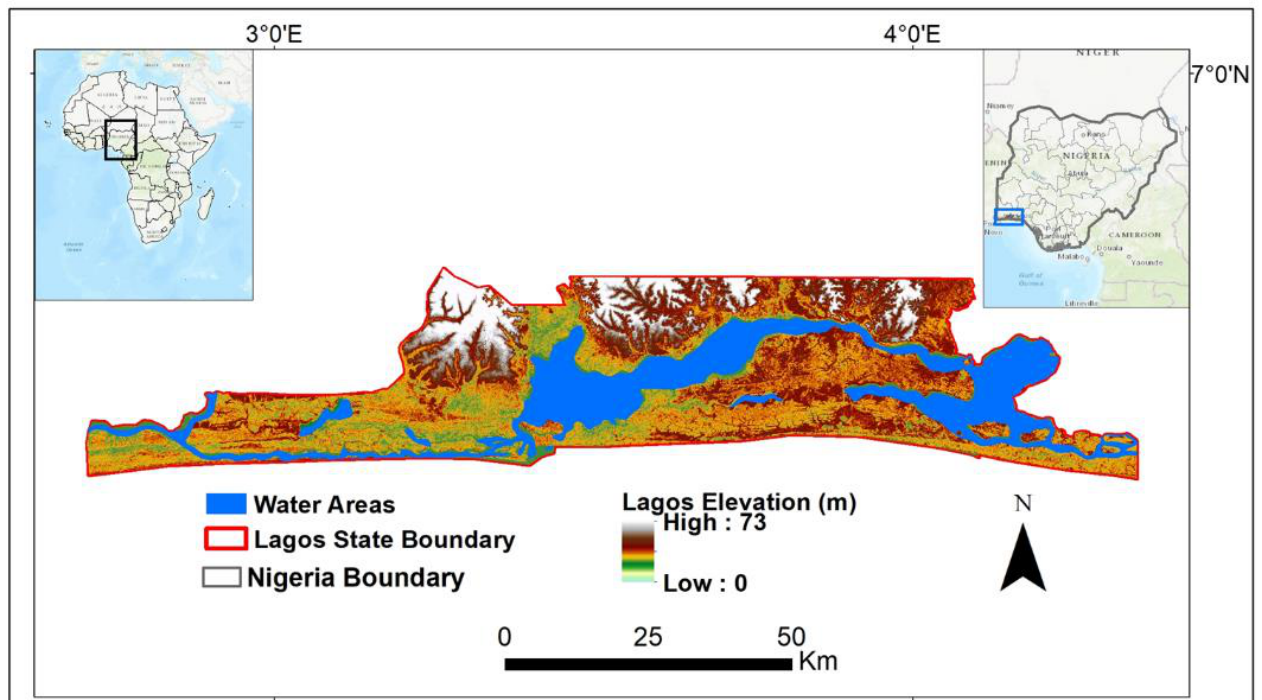
Figure 1. Location map of Lagos State.